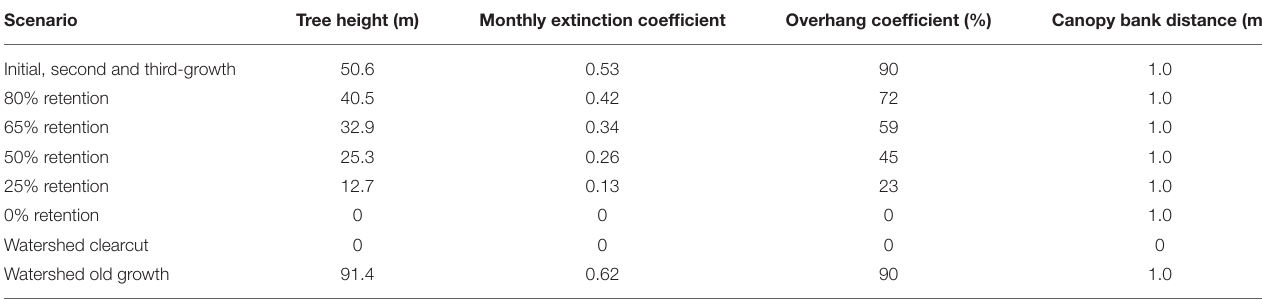
TABLE 3 | Watercourse buffer area characteristics used for each canopy reduction scenario evaluated.